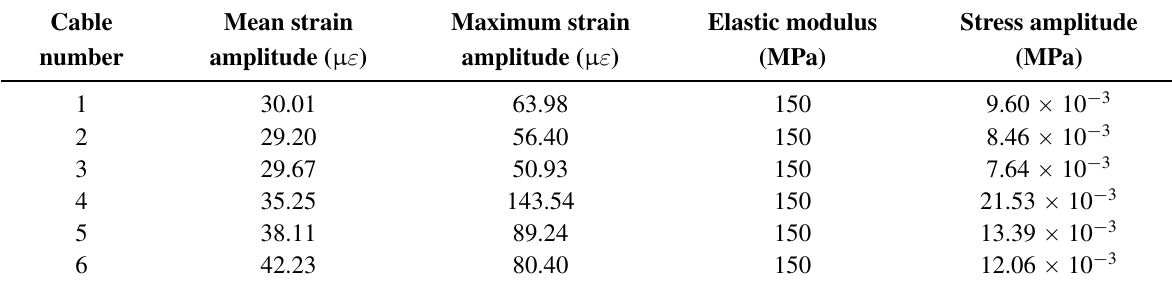
Figure 1. On-site strain measurement from HDPE cable sheathing. Table 1. Real fatigue load parameters for six tested cables.